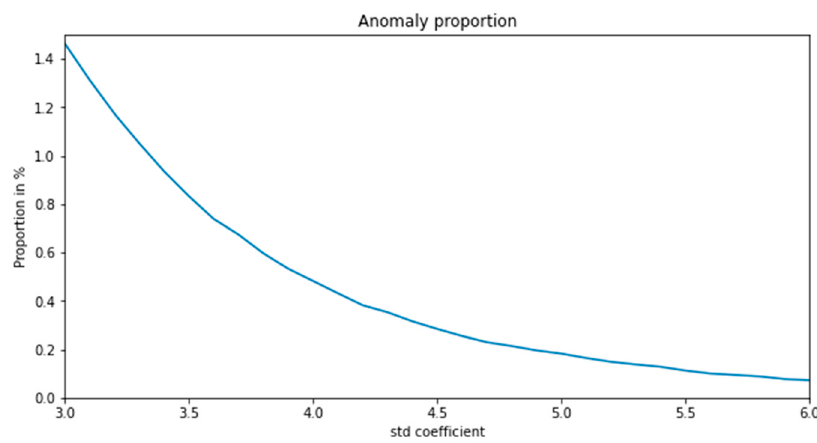
Figure 13. Flow chart of the anomaly detection process.